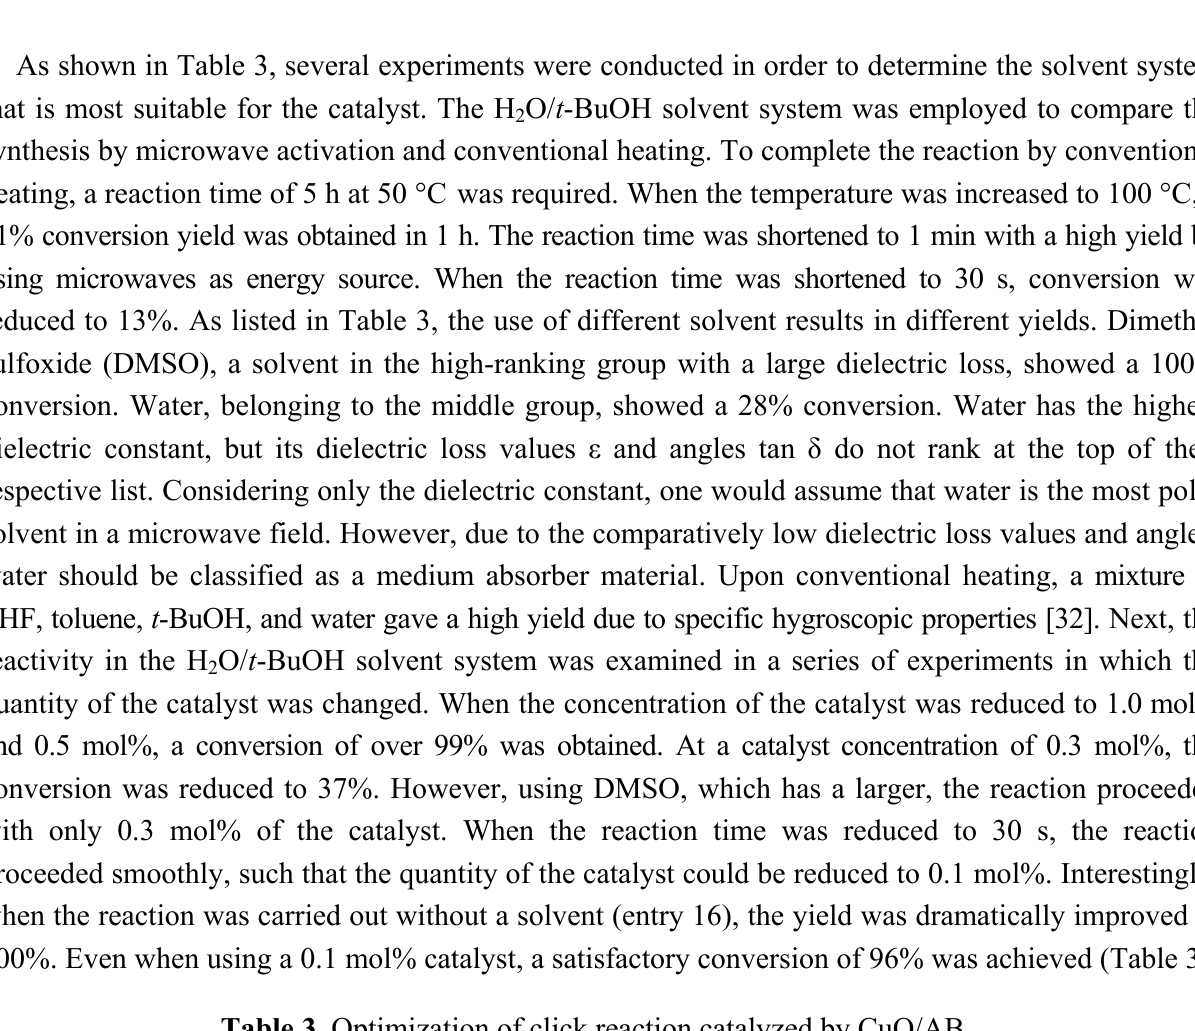
Table 3. Optimization of click reaction catalyzed by CuO/AB